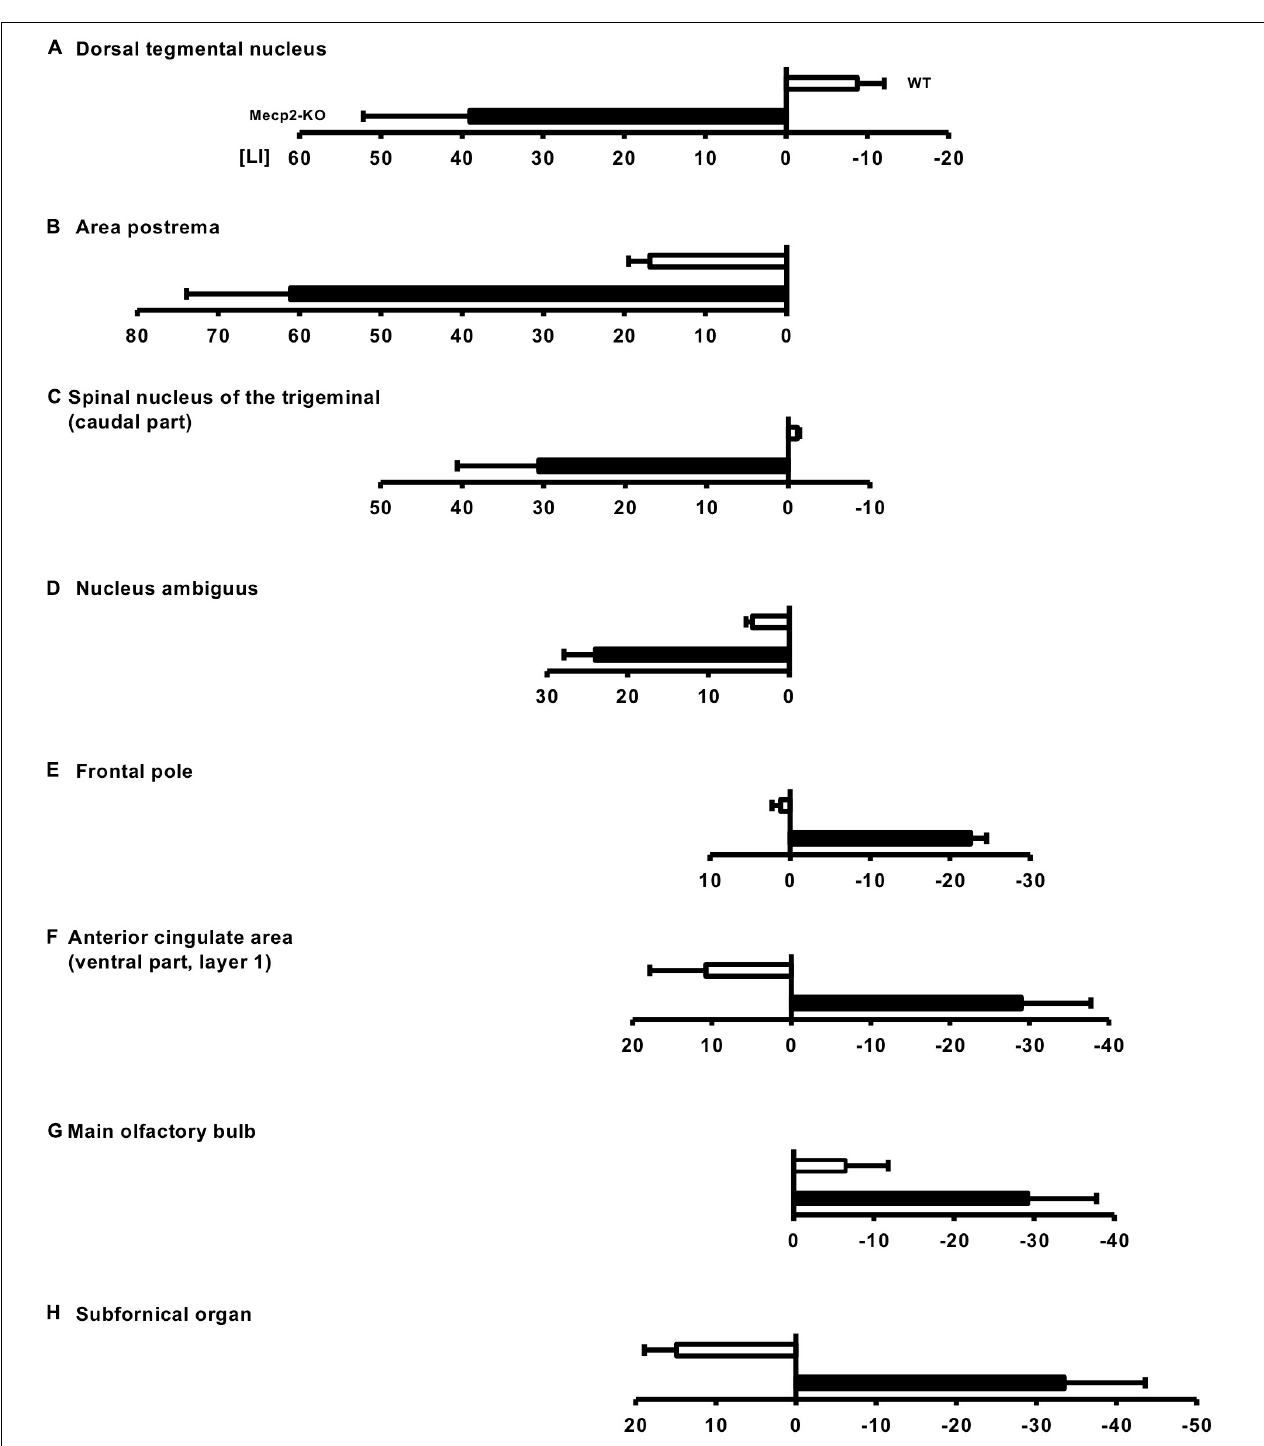
FIGURE 5 | Altered laterality of the regional brain volume in Mecp2 -KO mice. LI was calculated to evaluate the laterality of the regional brain volume in Mecp2 -KO mice. In total, 69 regions of the left hemisphere dominant were detected in Mecp2 -KO mice, including the dorsal tegmental nucleus (A) , area postrema (B) , spinal nucleus of the trigeminal (caudal part) (C) , and nucleus ambiguous (D) . Twenty regions of right hemisphere dominance were also detected in Mecp2 -KO mice, including the frontal pole (E) , anterior cingulate area (ventral part, layer 1) (F) , main olfactory bulb (G) , and (subfornical organ) (H) . n = 4 mice per group.